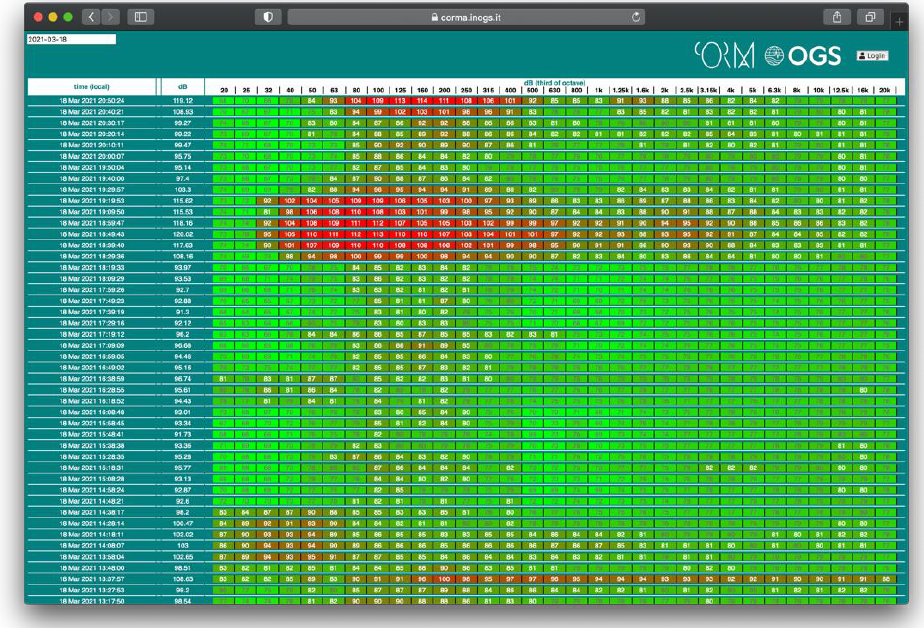
Figure 7. The web portal (https://corma.inogs.it (accessed on 6 April 2021)) [57] where the one-third octave band values are graphically represented in real time. It is easy to identify periods where the level of noise is higher and also in which frequency range.